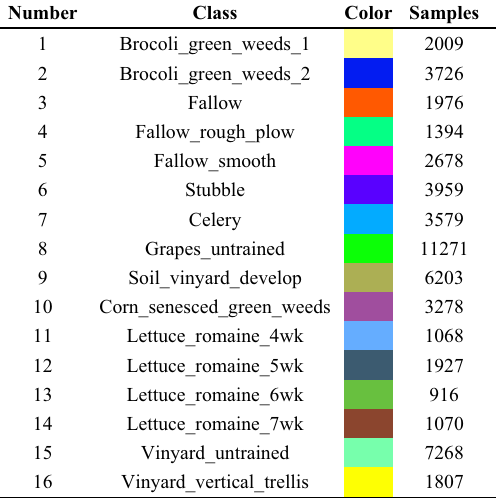
Table 4. The classification information of ground objects in Salinas Valley area.